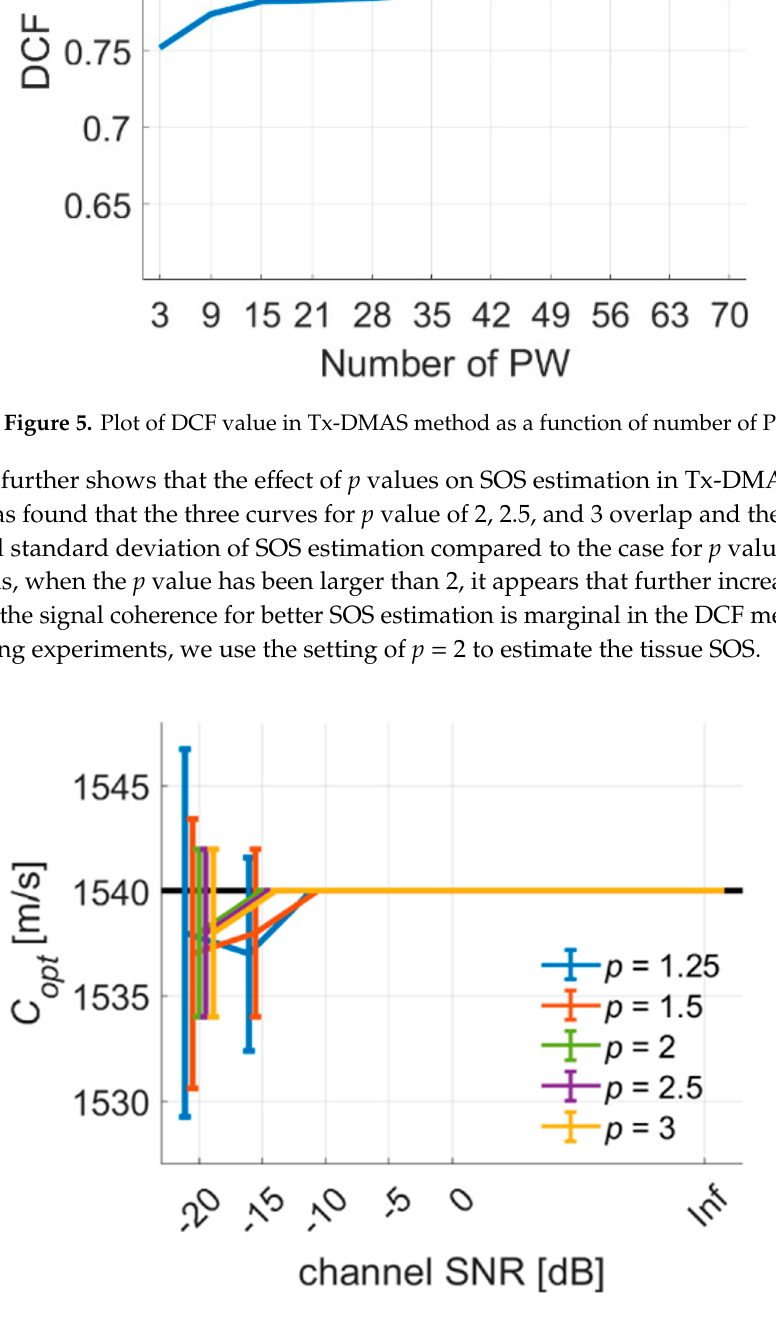
Figure 6. Plot of C opt in Tx-DMAS method with different p values as a function of channel SNR.